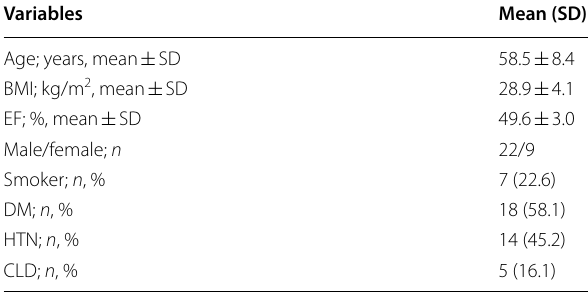
Data are presented as mean and standard deviation (mean